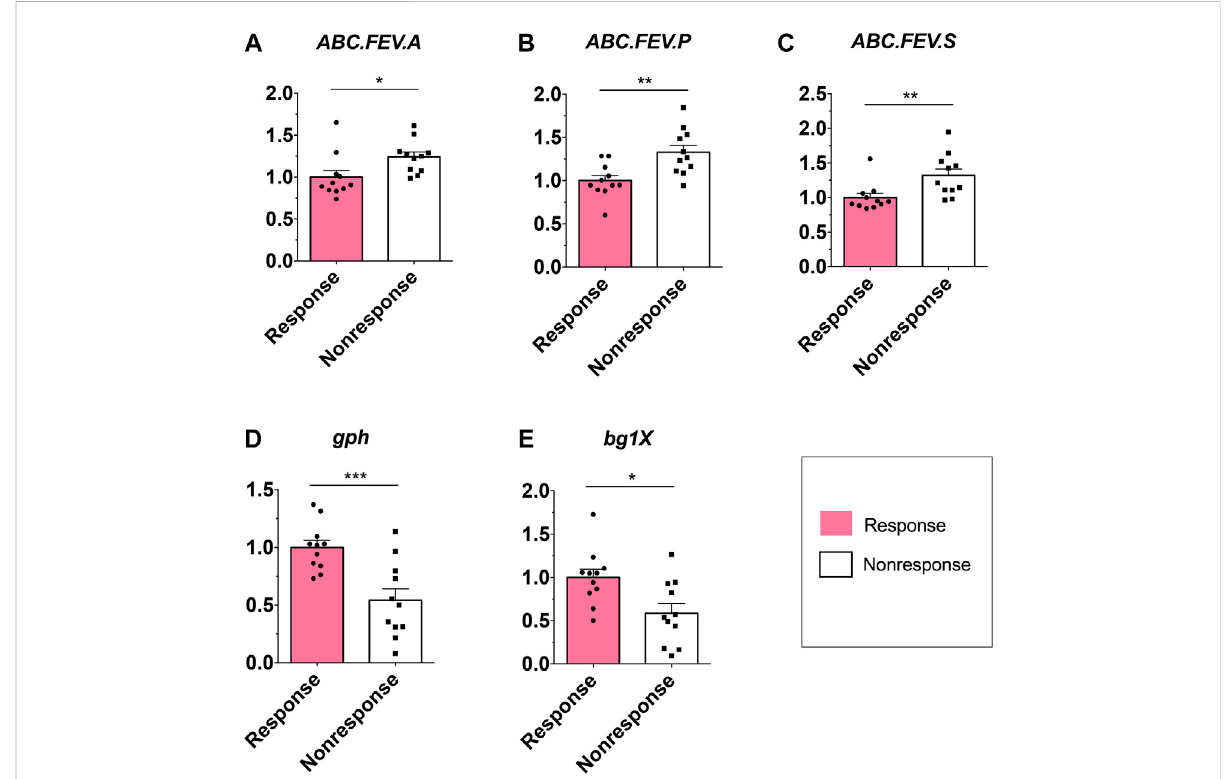
FIGURE 8 Relative abundance of candidate genes. Plotted values are qRT-PCR quanti fi cations of bacterial genes in starch and sucrose metabolism, glyoxylate and dicarboxylate metabolism, and the ABC transporters system. The abundance of ABC.FEV.A, ABC.FEV.P, and ABC.FEV.S, and gph and bglX were compared between the ADA-responsive group ( n = 11) and ADA-nonresponsive group ( n = 11). * p < 0.05; ** p < 0.01; *** p <